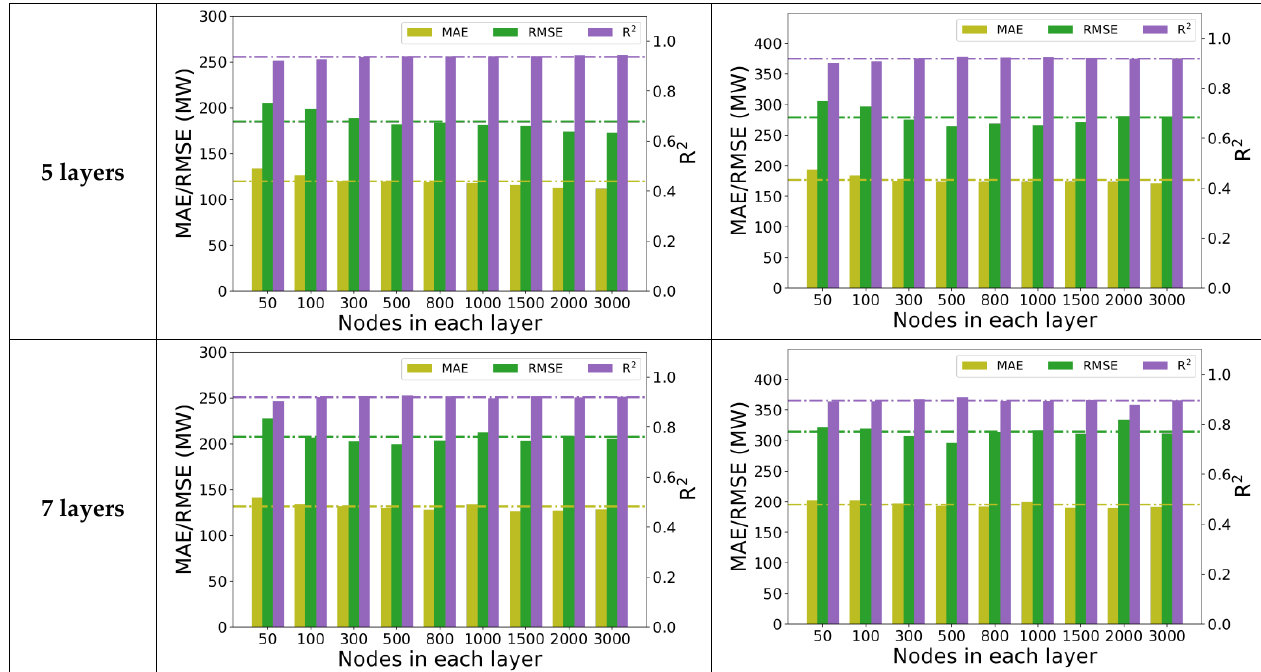
Figure 8. Model performance MAE/RMSE/ 𝑅 2 of models with different layers and nodes.